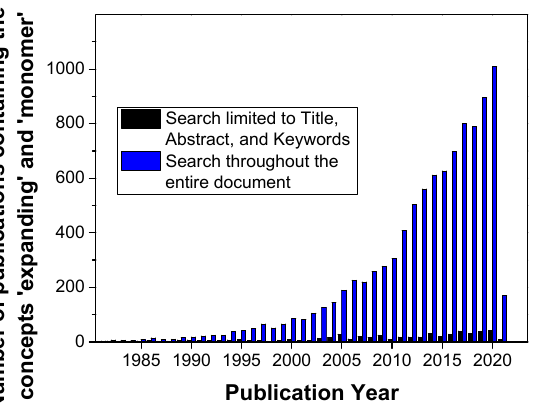
Figure 1. Evolution of the number of publications addressing the concepts of “expanding” and “monomer” during the last three decades. Literature search in the Scopus database on 13 February 2021.